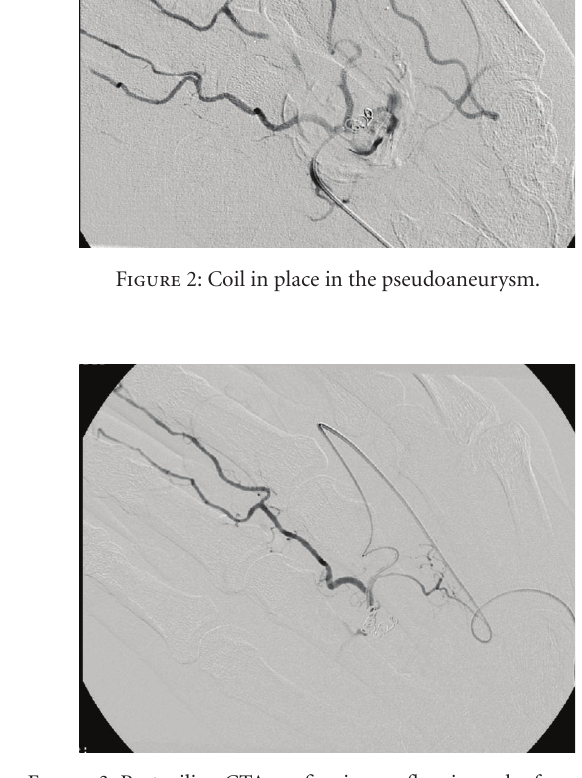
Figure 3: Postcoiling CTA confirming no flow in neck of pseudoa-